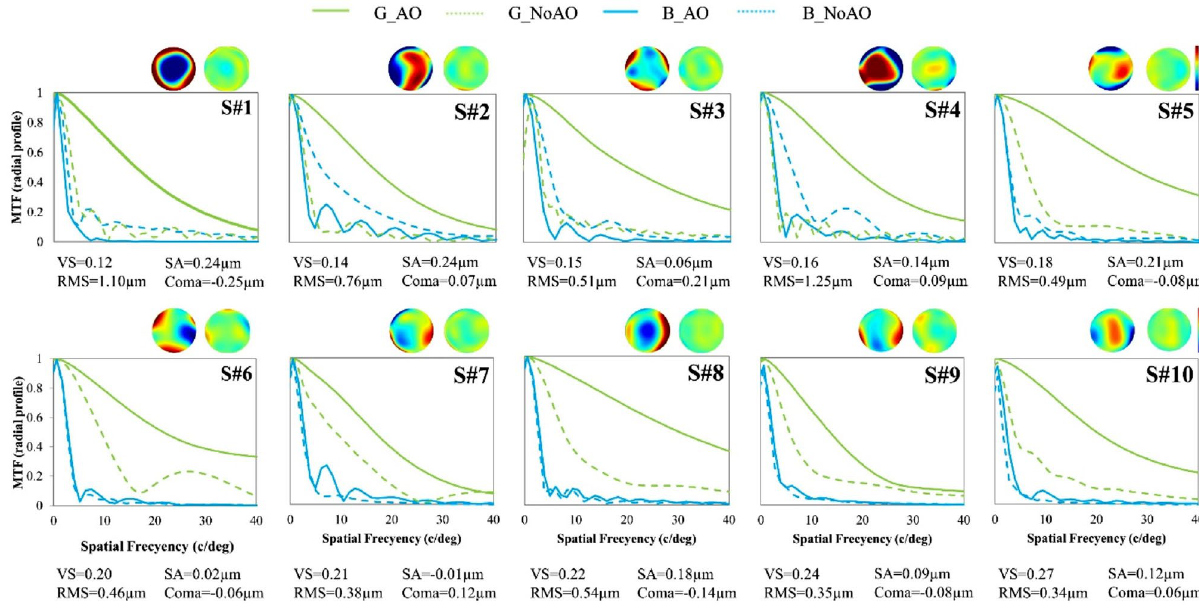
Figure 2. MTFs in all eyes, computed from the individually measured monochromatic aberrations. With natural aberrations (NoAO, dashed lines) and AO-corrected monochromatic aberrations (solid lines). MTFs are for best focus in green (G. 550 nm) and for the corresponding chromatic difference of focus (− 0.87 D, 450 nm) in blue. The maps above each graph represent monochromatic wave aberrations with no defocus and natural aberrations (left) and with AO-corrected aberration (right). Subjects are ordered according to increasing Visual Strehl (VS) value for 5-mm pupil diameters for the G_NoAO condition. Root Mean Square (RMS), Spherical Aberration (SA), and Coma values for NoAO correction (for the natural aberration condition) are shown in each panel under the subject’s label, unitless and μm units,